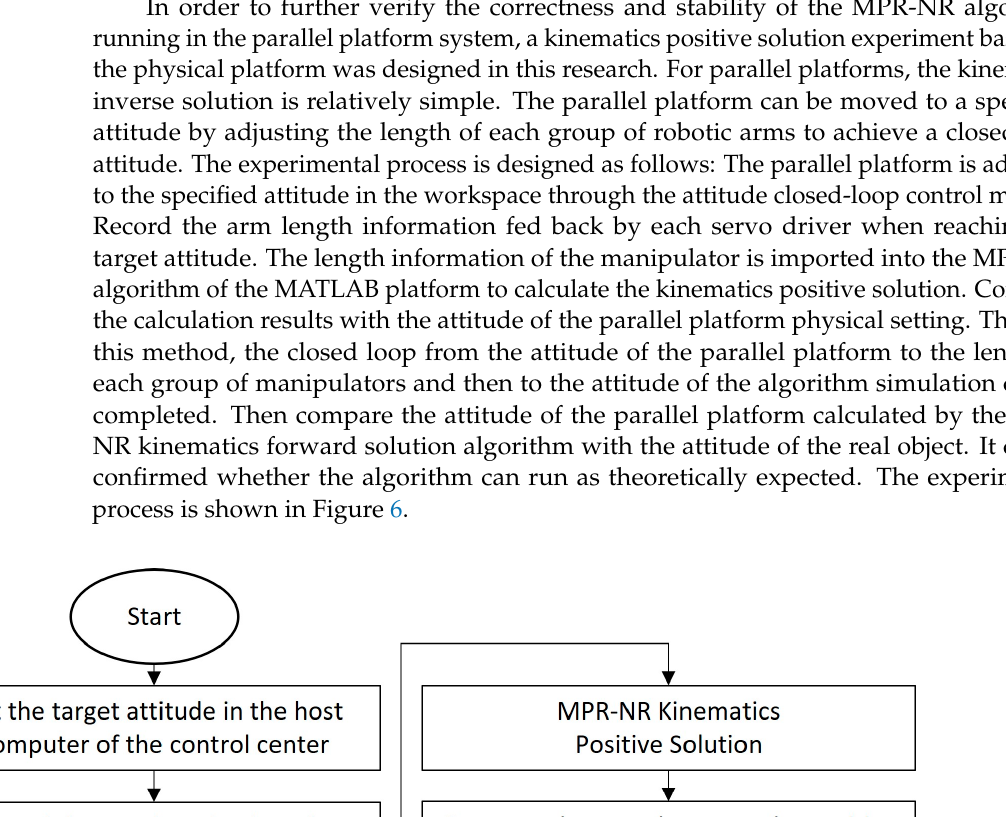
Figure 5. The relationship between stopping conditions and solution accuracy: ( a ) D ( L k ) and D ( X k ) relationship diagram; ( b ) D ( L k ) and iteration number relationship diagram. Both 𝐷(𝐿 (cid:3038) ) and 𝐷(𝑋 (cid:3038) ) in Figure 5a are logarithmic images with base 10. It can be